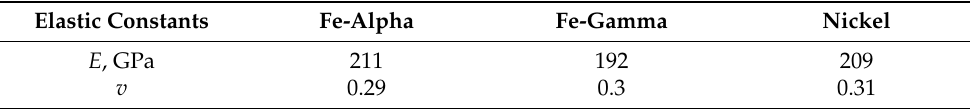
Table 7. Elastic constants used for residual stress calculations.